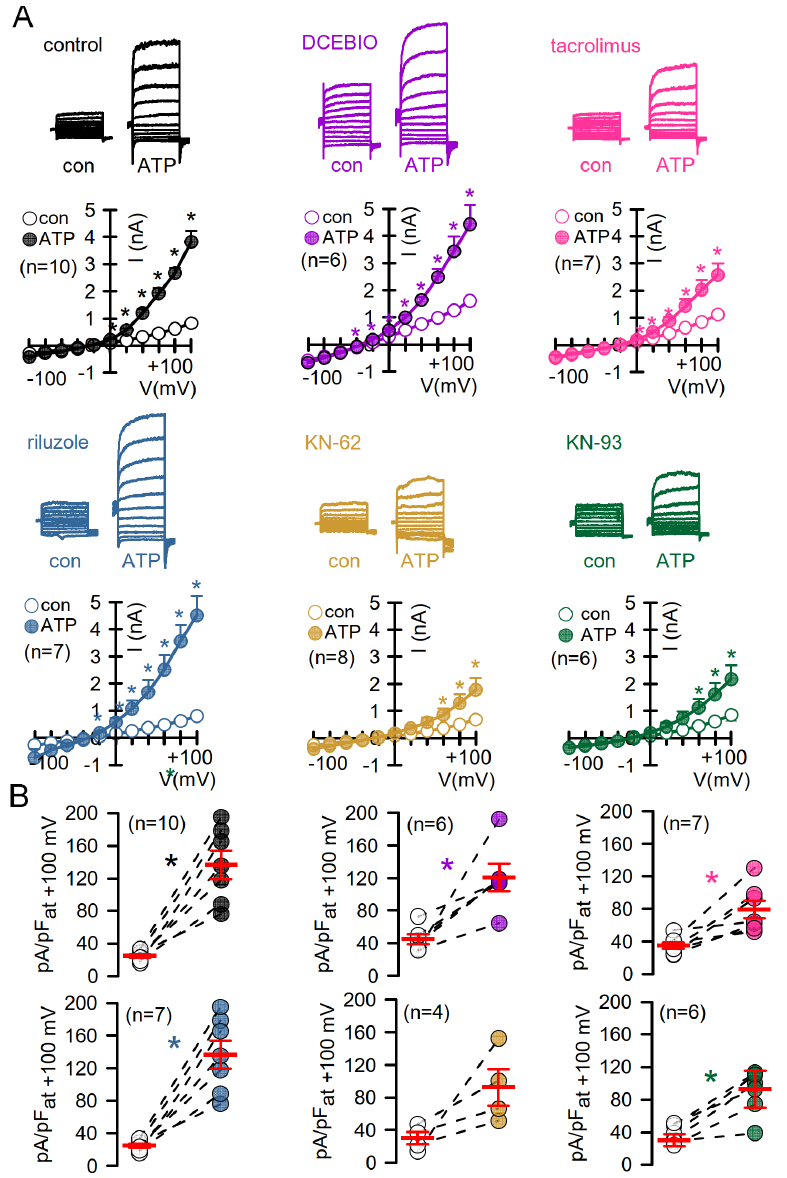
Figure 5. Evidence for CAMKII-dependent activation of TMEM16A but not for CAM- or calcineurin-dependent regulation of endogenous TMEM16A in CFBE airway epithelial cells. ( A ) Whole cell patch clamp analysis of ATP (100 µ M)-activated TMEM16A currents and effects of the 1-EBIO analogues DCEBIO and riluzole (both 10 µ M), the CAMKII-inhibitors KN-62 and KN-93 (both 10 µ M) and the calcineurin inhibitor tacrolimus (10 µ M). Cells were pre-incubated with the compounds, which were also present during the experiment. Under all conditions, significant activation of whole cell currents by ATP was observed. While the KCNN4 activators DCEBIO and riluzole enhanced ATP-activated currents, KN-62, KN-93, and tacrolimus reduced current activation. The time course for ATP-activation of TMEM16A remained unchanged by the drugs. ( B ) Calculated current densities. All experiments were performed in the presence of the KCNN4-inhibitor TRAM-34. Mean ± SEM (n = number of experiments). * Significant activation by ATP ( p < 0.05; paired t